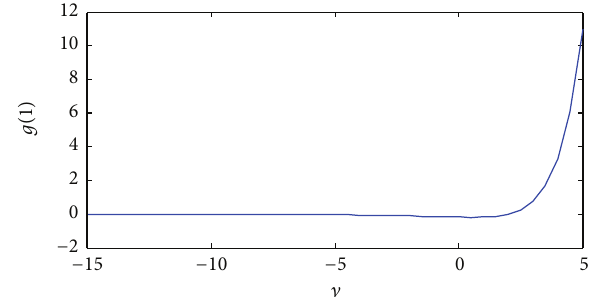
Figure 6: 𝑔(1) for different 𝛾 ( 𝛾 ∈ [2.5, 10] ).